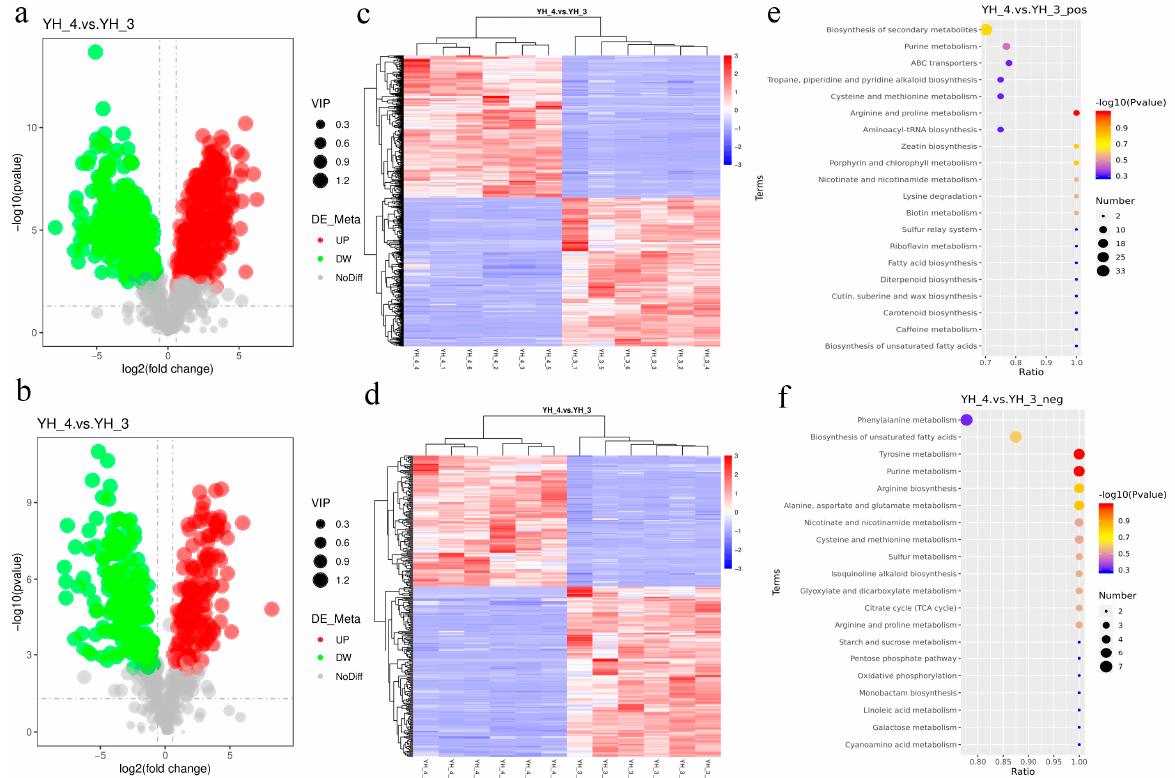
Figure 5. DAMs analysis in YH_4 vs. YH_3. ( a ) Volcano plot of differential metabolites in positive polarity mode. ( b ) Volcano plot of differential metabolites in negative polarity mode. Each point in the volcano map represents a metabolite, and the X-axis represents the logarithm of the quantitative difference of a certain metabolite in the two samples; the Y-axis represents the difference in the signi fi cance level ( − log10p value). The green dots represent downregulated DAMs, the red dots represent upregulated DAMs, and the gray dots represents DAMs that were detected but not sig- nificantly changed. ( c ) HCA of DAMs in YH_4 vs. YH_3 in positive polarity mode. ( d ) HCA of DAMs in YH_4 vs. YH_3 in negative polarity mode. ( e ) Scatter plot of KEGG pathways enriched in YH_4 vs. YH_3 in positive polarity mode. ( f ) Scatter plot of KEGG pathways enriched in YH_4 vs. YH_3 in negative polarity mode. The abscissa in the figure represents the ratio of the number of differential metabolites in the corresponding metabolic pathway, to the number of total metabolites identified in the pathway. The greater the value, the higher the degree of enrichment of differential metabolites in the pathway. The color of the point represents the p -value of the hypergeometric test. The smaller the value, the greater the reliability and statistical significance of the test. The size of the point represents the number of differential metabolites in the corresponding pathway. The larger the point, the more differential metabolites in the pathway.